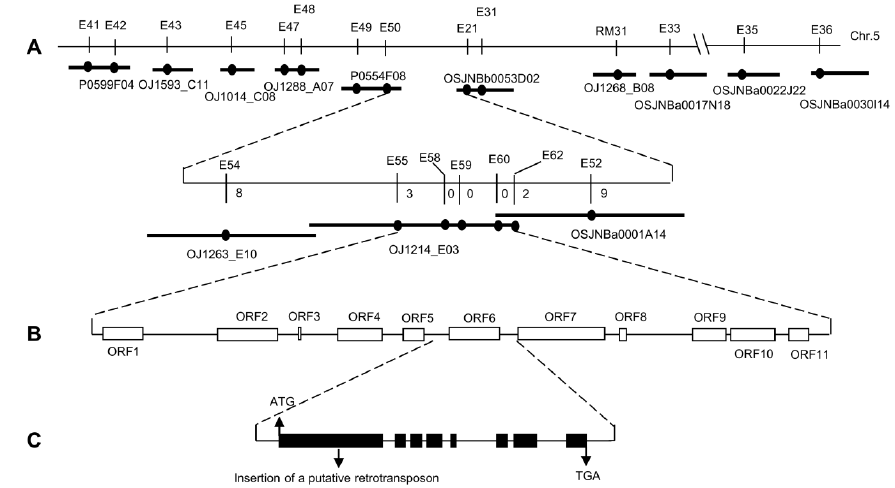
Figure 2. The positional cloning of RLS1 . ( A ) RLS1 was first found to be linked to the SSR